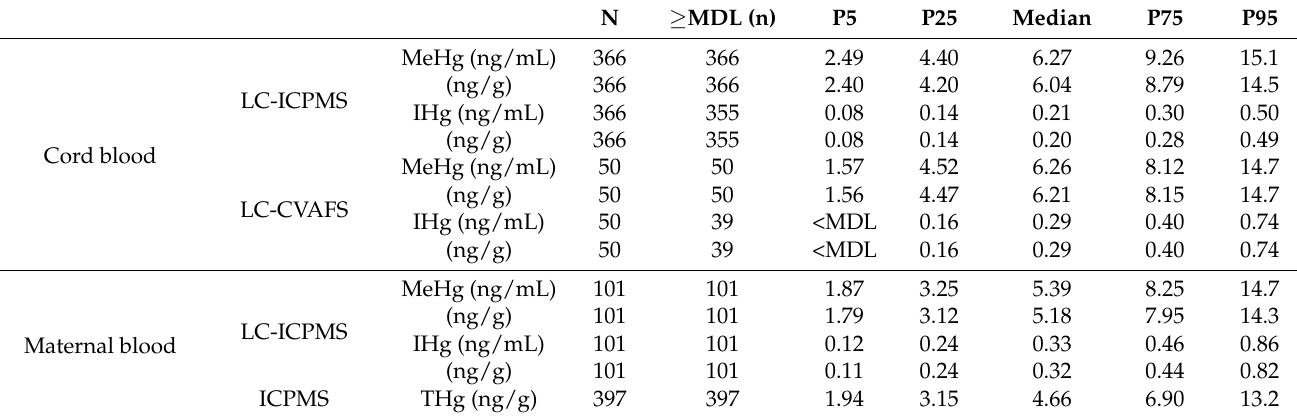
Table 4. Concentrations of methylmercury and inorganic mercury in blood samples from the Japan Environment and Children’s Study (JECS) pilot study.